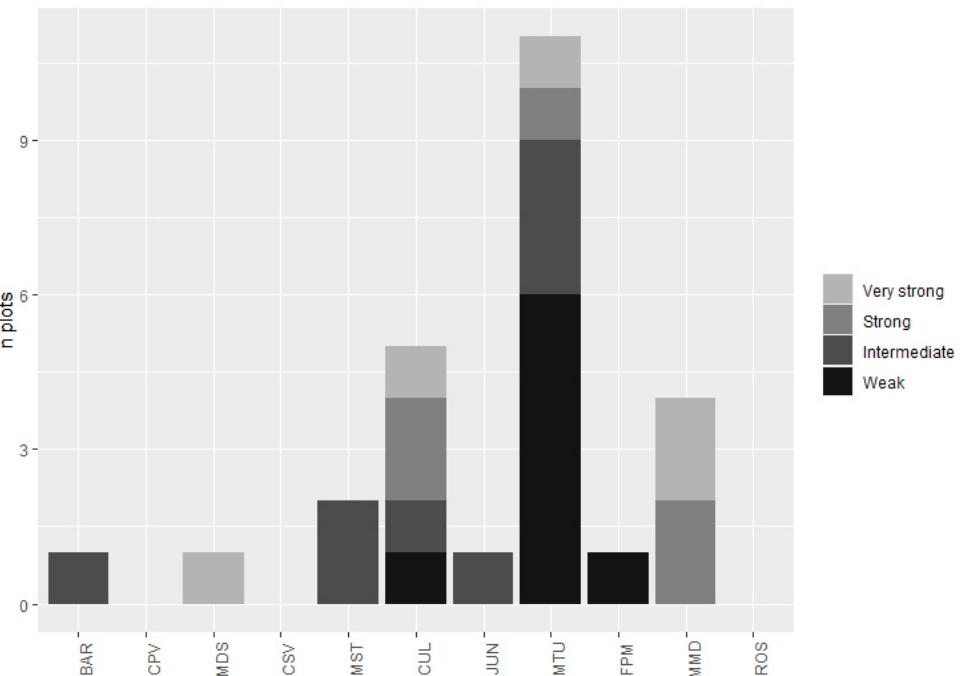
Figure 6. Strength of significant negative change in each land cover class. BAR: barren land; CPV: cushion plant vegetation; MDS: mountain deserts; CSV: cryophytic and subnival vegetation; MST: mountain steppes; CUL: cultivated land; JUN: juniper vegetation; MTU: mountain Tugai; FPM: floodplain meadows; MMD: mountain meadows; ROS: Rosaceae scrubs.